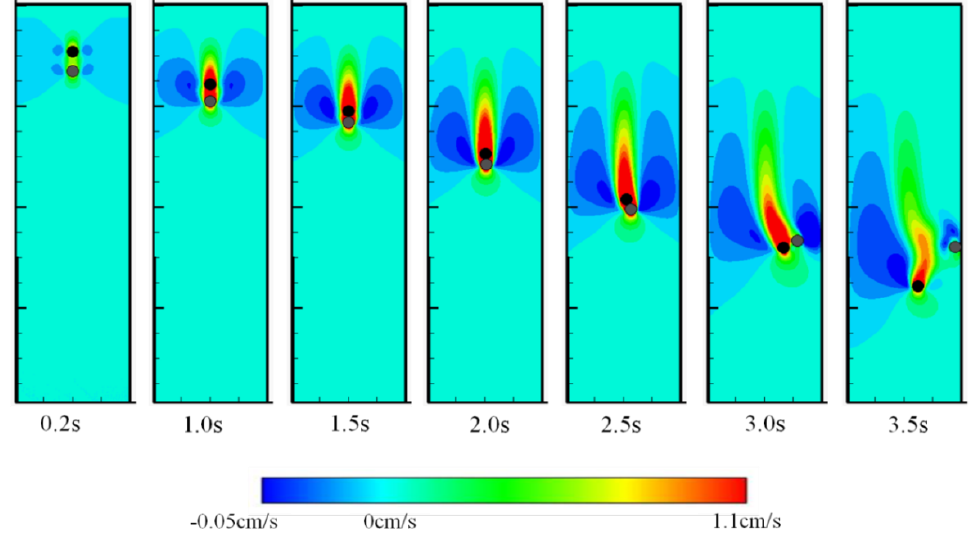
Figure 1. The sedimentation process of two circular particles in a channel and corresponding flow fields at different time stages.